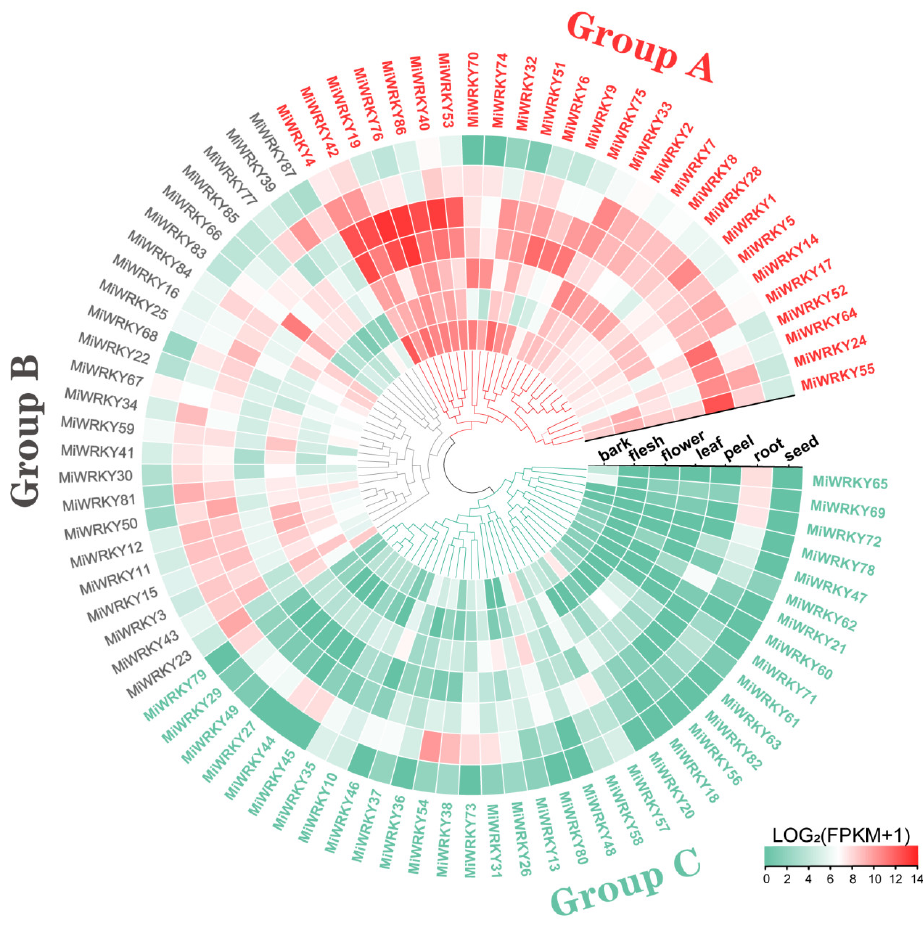
Figure 6. Hierarchical clustering of mango WRKY expression profiles in different tissues. The 87 MiWRKY genes are divided into Groups A-C. The color bar represents the expression value. Anthocyanin concentrations and expression patterns of MiWRKY1 , MiWRKY2 , MiWRKY3 , MiWRKY5 , MiWRKY81 , and MiWRKY84 were analyzed by postharvest UV-B/visible light treatment. No anthocyanin content was detected in fruit peel under darkness during the whole period, while the accumulation of anthocyanin in UV-B/visible-light-treated fruit was started at six days of irradiation and peaked at ten days (Figure 8a). Among the six MiWRKYs , only MiWRKY1 and MiWRKY81 responded to UV-B/visible light treatment. The expressions of these two genes were induced at one day of treatment and remained at high levels afterwards (Figure